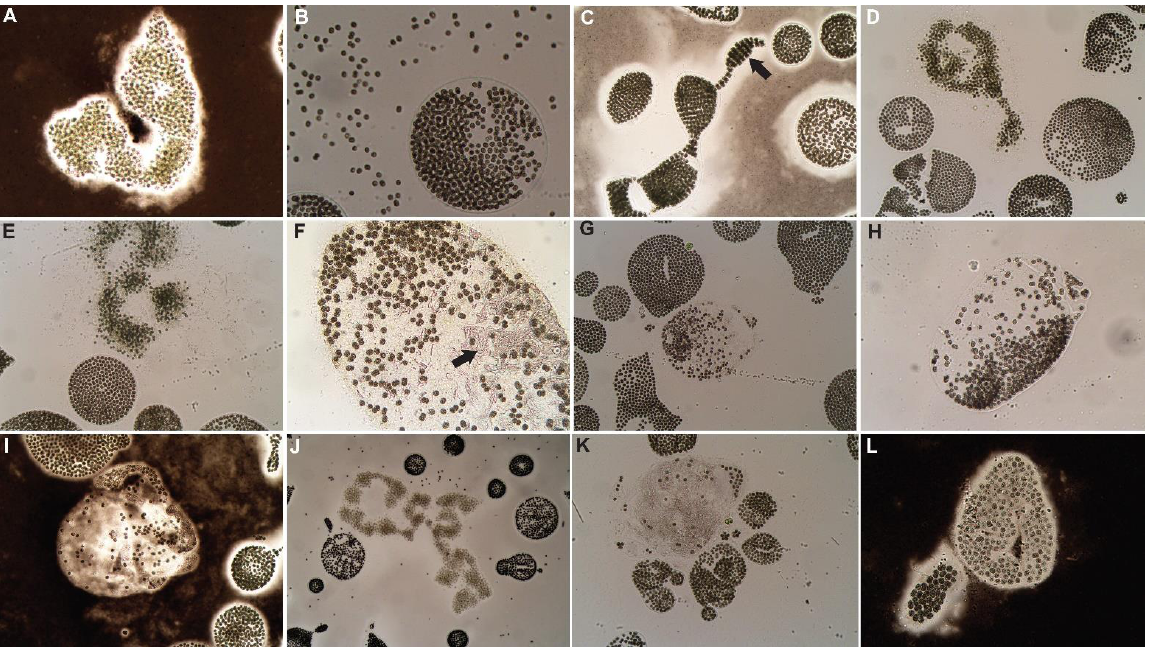
Figure 5. Microcystis colonies 72 h post-treatment with herbicides and herbicide + algaecide combi- nation treatment. Clipper ® SC + Algimycin ® PWF: ( A ) dead M. aeruginosa colony, ( B ) decaying M. aeruginosa colony with released cells. Tradewind ® SC + Algimycin ® PWF: ( C ) new growth of M. wesenbergii , indicated by arrow, ( D ) discolored M. aeruginosa colony. Hydrothol ® 191: ( E ) bleaching of M. aeruginosa colony, ( F ) breakdown of M. wesenbergii colony with clumping mucilage, indicated by arrow. Tribune™ + Cutrine ® Ultra: ( G ) breakdown and bleaching of M. wesenbergii colony, ( H ) breakdown of M. wesenbergii colony. Hydrothol ® 191 + GreenClean ® Liquid 5.0: ( I ) breakdown of M. wesenbergii colony, ( J ) dead M. aeruginosa colony. Tribune™ + Hydrothol ® 191: ( K ) breakdown of M. wesenbergii colony with clumping mucilage, ( L ) bleaching of M. wesenbergii cells.